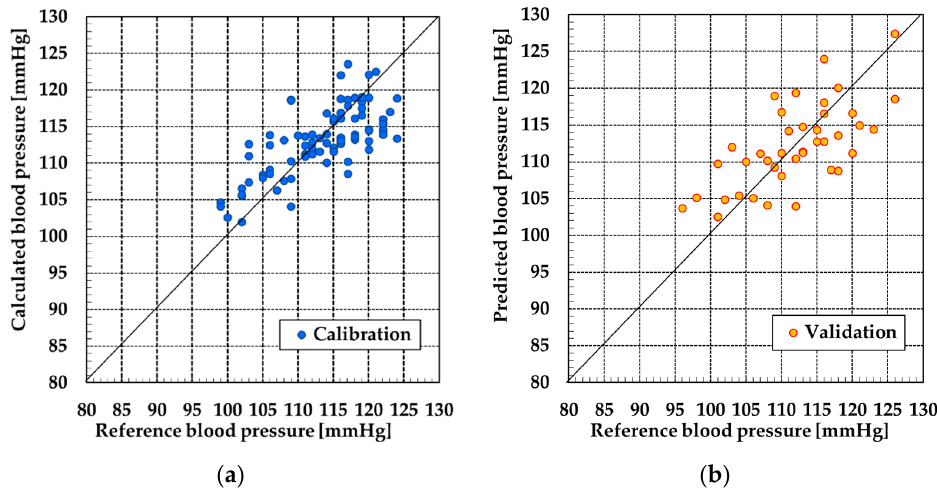
Figure 9. Result at systolic blood pressure (SBP) by partial least squares regression (PLSR) of subject A: ( a ) calibration and ( b ) validation.